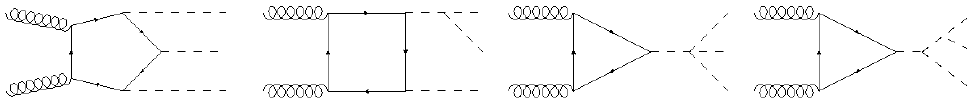
Figure 1 . Diagrams that contribute to the LO triple Higgs production in the gluon fusion channel (modulo permutations of the (cid:12)nal state bosons). We identify the pentagon P (left), box B (second from left) and triangles T 4 and T 3 (right) diagrams, respectively.